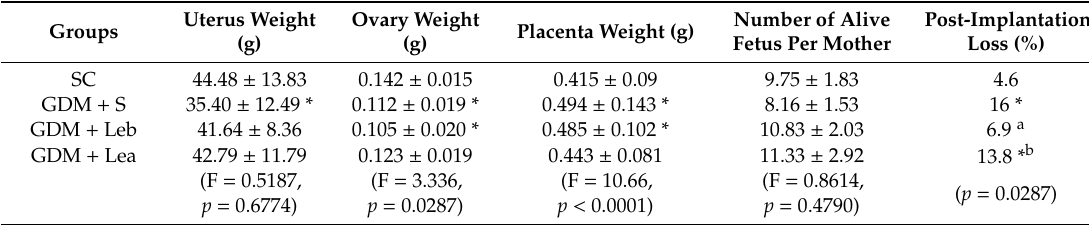
Table 1. Reproductive capacity of female rats.